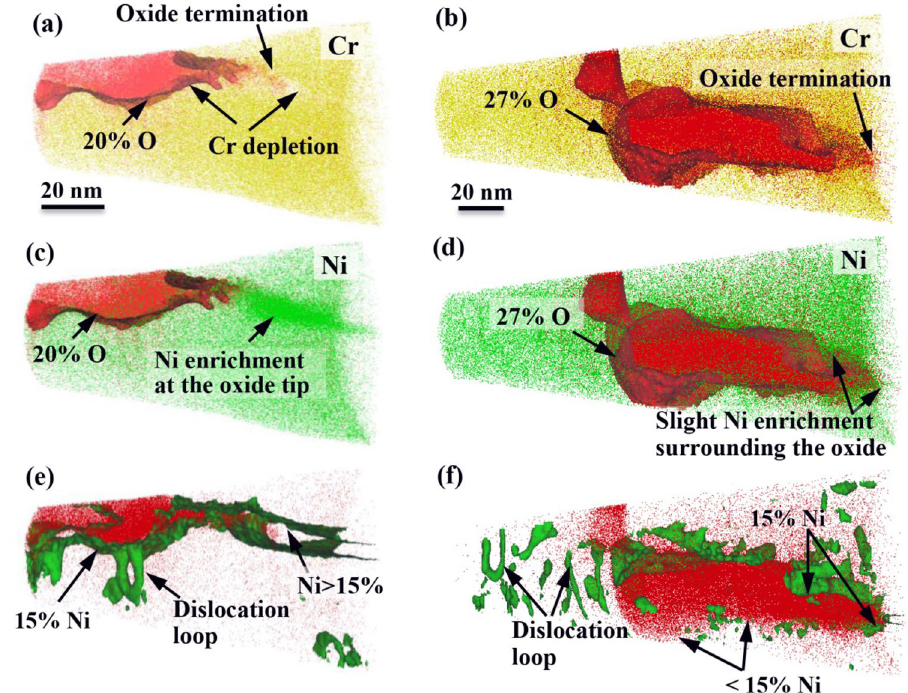
Figure 4. APT analysis of element distributions at the grain boundary oxide/matrix interfaces on the 0.5- and 3-dpa irradiated specimens after exposure for 500 h in primary water at 320 °C. ( a ) and ( b ) Cr distributions ahead of the oxides. ( c ) and ( d ) Ni distributions ahead of the oxides. ( e ) and ( f ) Iso-concentration surface plot of Ni at 15% (green). A localized Ni enrichment with a concentration of 67 at% ahead of the oxide was observed on the 0.5-dpa irradiated specimen, while the 3-dpa irradiated specimen showed a slight enrichment of Ni ahead of the whole interface between the oxide and the matrix. *Element distributions in this figure were reconstructed using the commercial CAMECA Imago Visualization and Analysis Software package (IVAS, Version 3.6.8). URL link: https:// www. cameca.